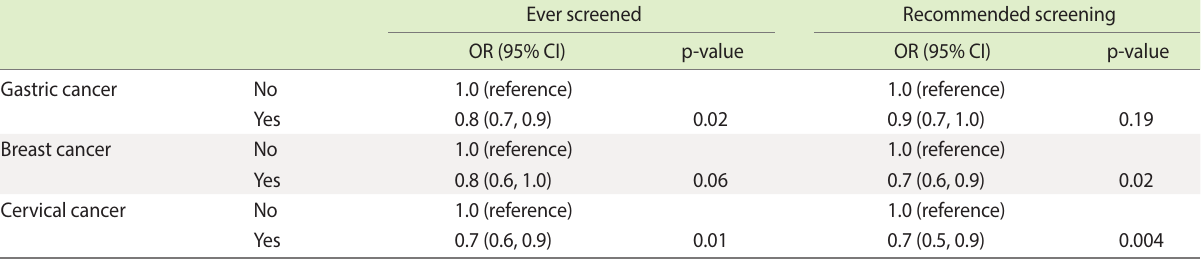
Table 5. Multivariate logistic regression 1 in diabetic and non-diabetic participants Ever screened Recommended